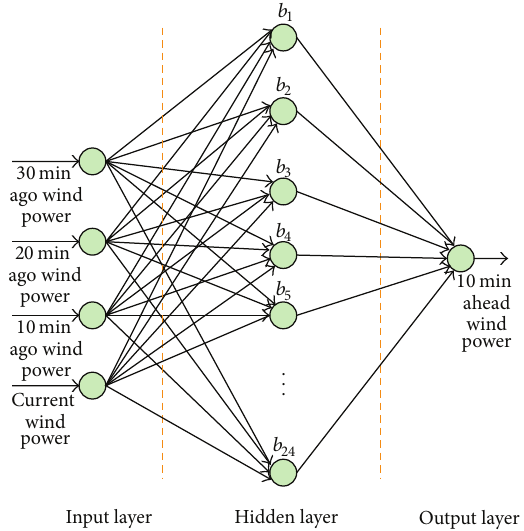
Figure 2: The architecture of the proposed RBF neural network based wind power forecasting